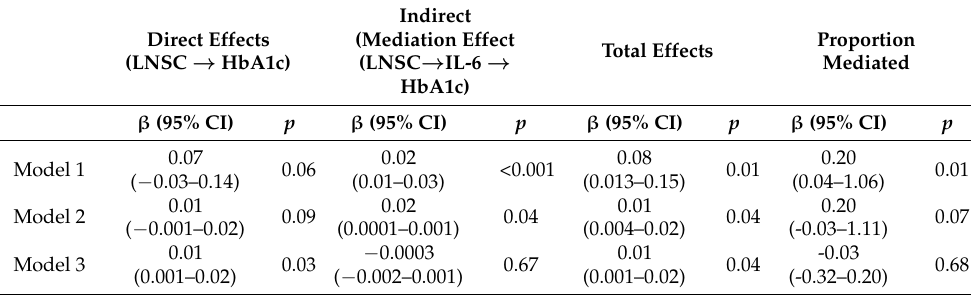
Table A3. β estimates (95% CI, p -value) of late-night salivary cortisol (LNSC) measurement on HbA1c via IL-6 as a mediator, and the proportion of association between cortisol and HbA1c mediated by IL-6 ( n =